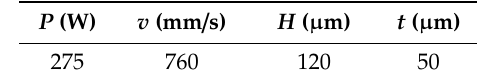
Table 1. SLM parameters to fabricate Inconel 718 alloy specimens.